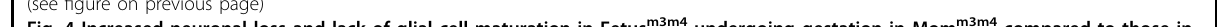
p = 0.017) compared to microglia in Mom WT – Fetus m3m4 (Fig. 4F). The signi fi cantly lower integrated density of Iba1 expression in addition to the rounded microglial mor- phology indicated a lack of microglial maturation in Mom m3m4 – Fetus m3m4 (Mean ID: 15,269 vs. 5899; p = 0.0001; Fig. 4G).